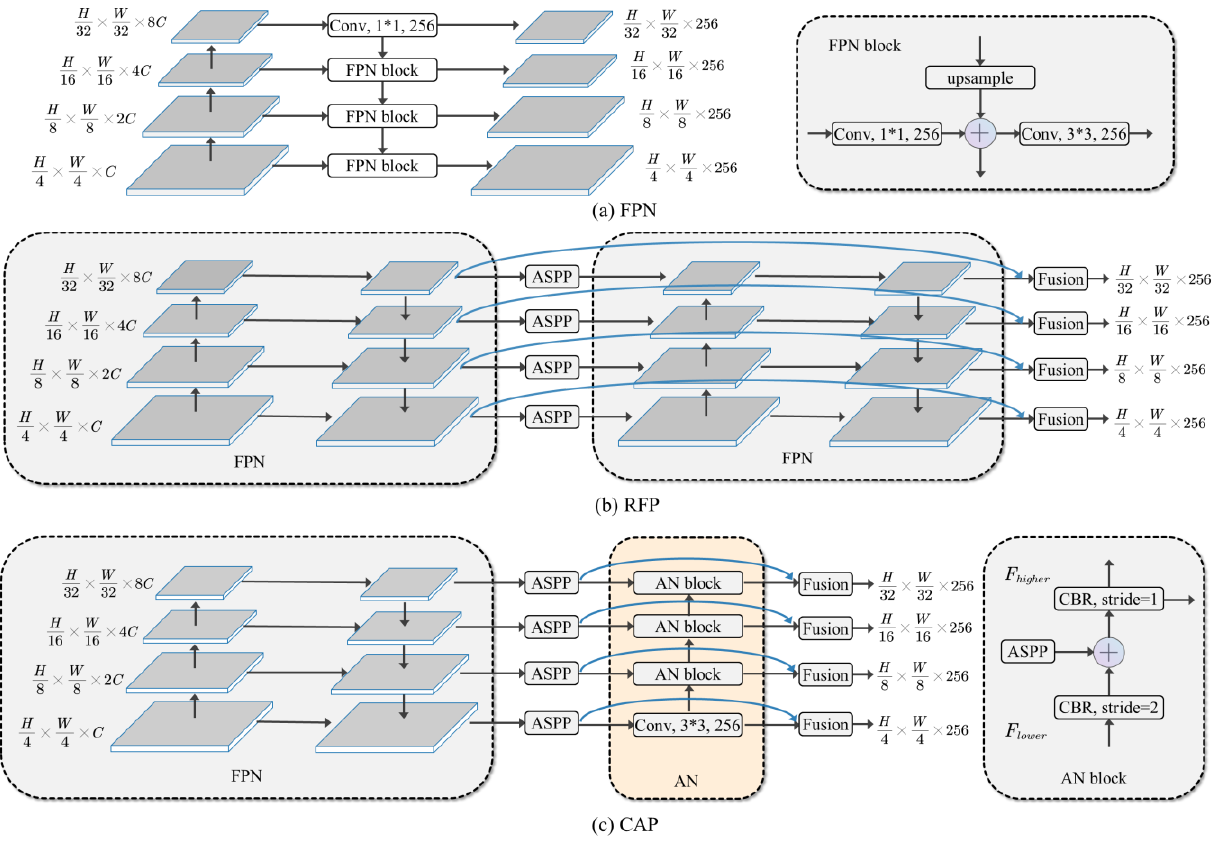
Figure 4. Comparison among feature fusion networks.